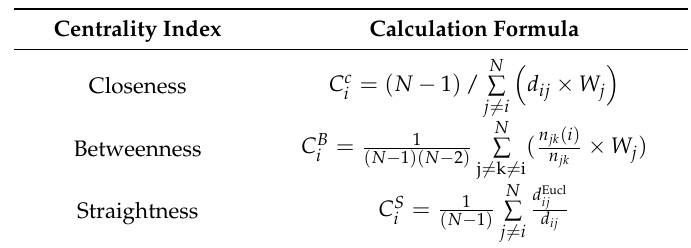
Table 2. Calculation formulas for centrality